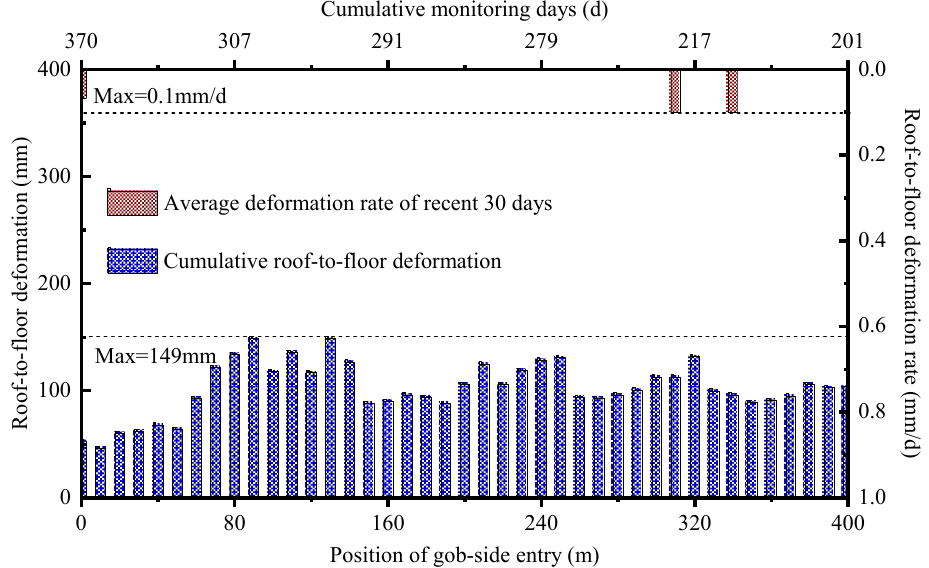
Figure 14. Roof-to-floor displacement monitoring results.